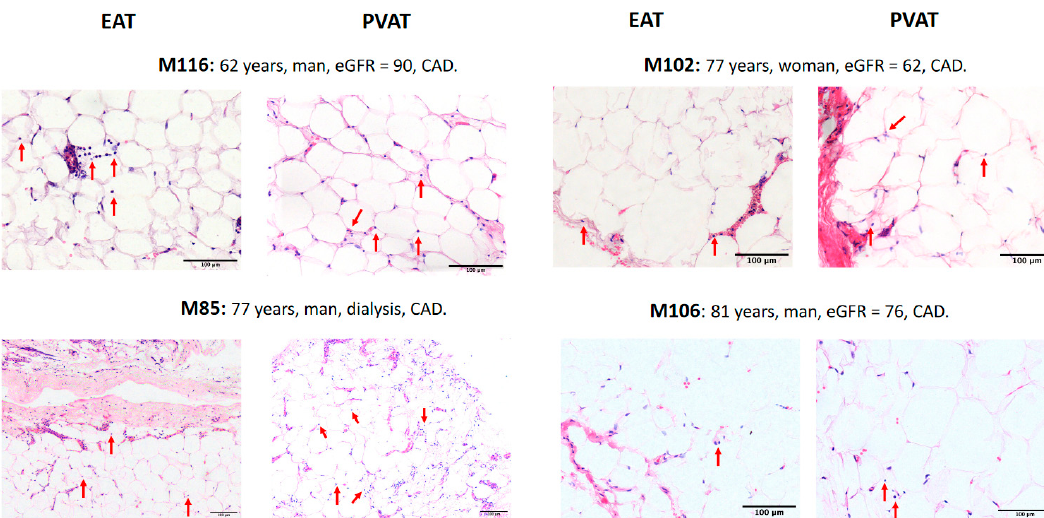
Figure 3. Severity of adipose tissue inflammation evaluated by a semi-quantitative scoring system based on the number of mononuclear infiltrated cells per adipocyte. Shown are representative samples of EAT and PVAT from four di ff erent patients. Infiltrating mononuclear cells are indicated by red arrows. The extent of adipose tissue inflammation was evaluated by scoring the number of infiltrating mononuclear cells per adipocyte cell. Scores were “none” (score = 0) when there were less than 2 inflammatory cells / adipocyte, “one” (greater than minimal), or “two” (when severe capillary hyperemia was observed). Bars show magnification. Abbreviations: CAD = coronary artery disease, EAT = epicardial adipose tissue, eGFR = estimated glomerular filtration rate, PVAT = perivascular adipose tissue. Scale bar = 200 µ m.